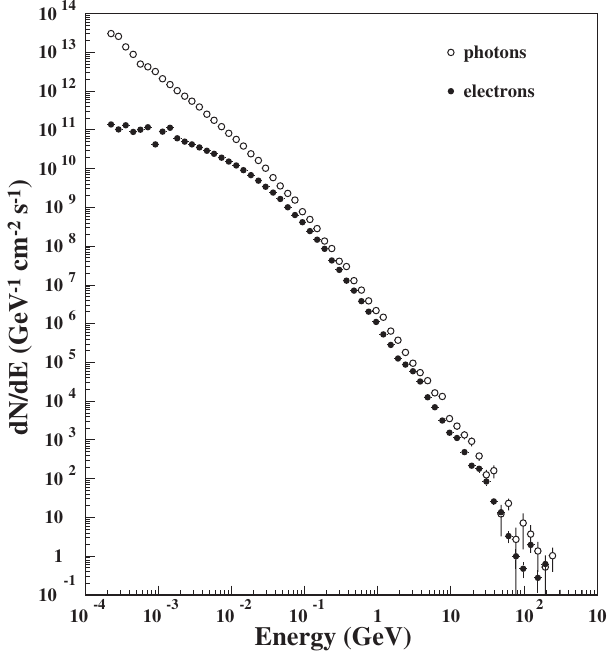
FIG. 8. Energy spectra of electrons and photons averaged over the hottest spot in the inner Nb